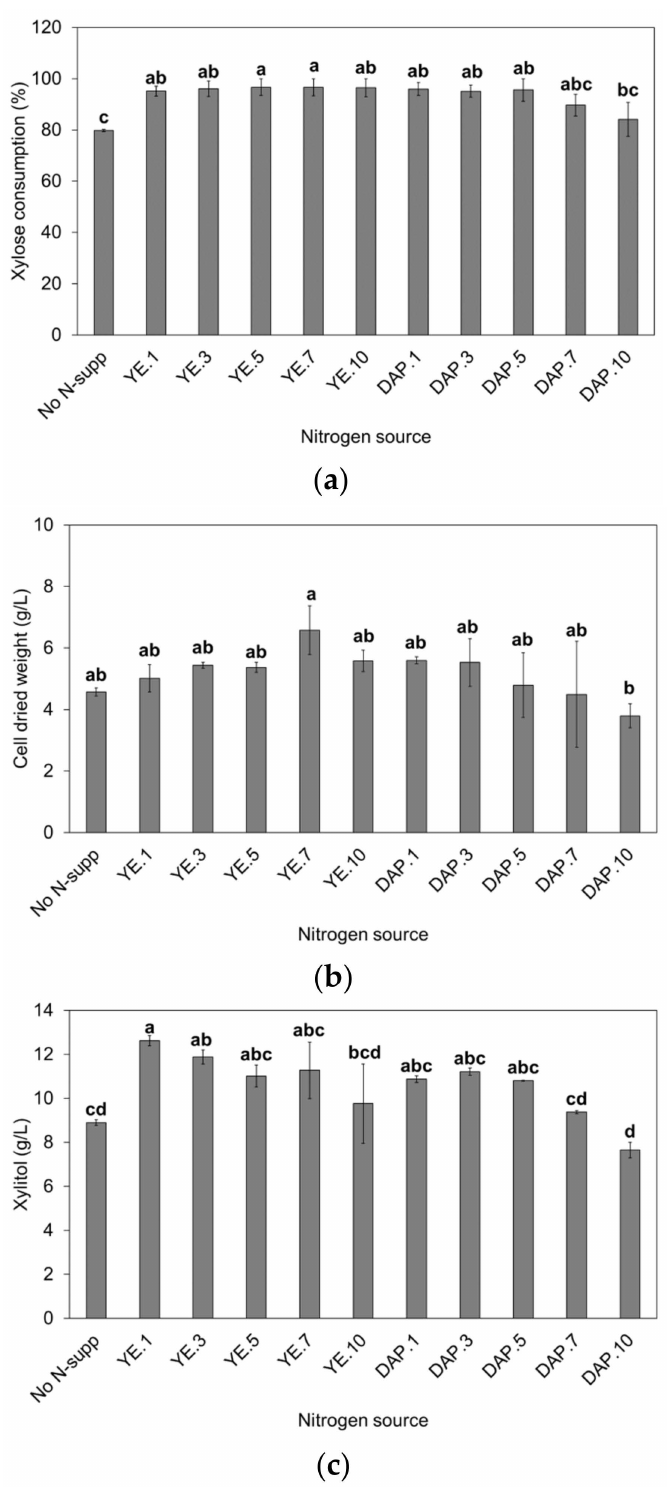
Figure 2. Comparisons of ( a ) xylose consumption, ( b ) cell dry weight, and ( c ) xylitol from fermen- tation of C. guilliermondii TISTR5068 in vinasse from sugarcane hydrolysate-based ethanol broth supplemented with yeast extract (YE) or diammonium phosphate (DAP), cultivated at 30 ◦ C, 200 rpm for 60 h. Numbers following the abbreviations indicate concentration of the respective nitrogen source in g/L. The same letters above the bars indicated non-significant difference in mean